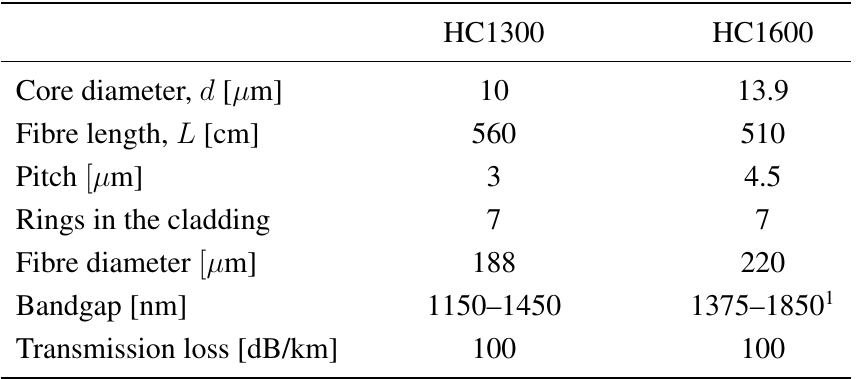
Table 1. Specifications of the HC-PBFs used in the